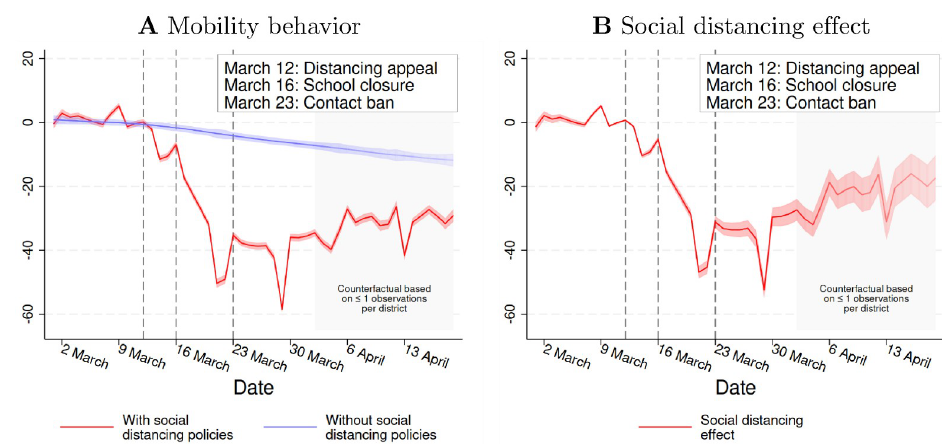
Fig 3. The social distancing effect on mobility. Notes : Fig 3A and 3B show how social distancing policies affect mobility behavior. Fig 3A demonstrates how individuals’ behave in the realized world with social distancing policies (red line) and in the counterfactual world without SD policies (blue line). The spike on March 29 reflects very bad weather conditions at this particular day. Fig 3B shows the implied social distancing effect, measured in percentage points. The three vertical lines mark the Chancellor’s appeal for social distancing (March 12), the nationwide school closures (March 16), and the nationwide contact bans (March 23). The dashed lines represent 95% confidence intervals based on district-level-clustered standard